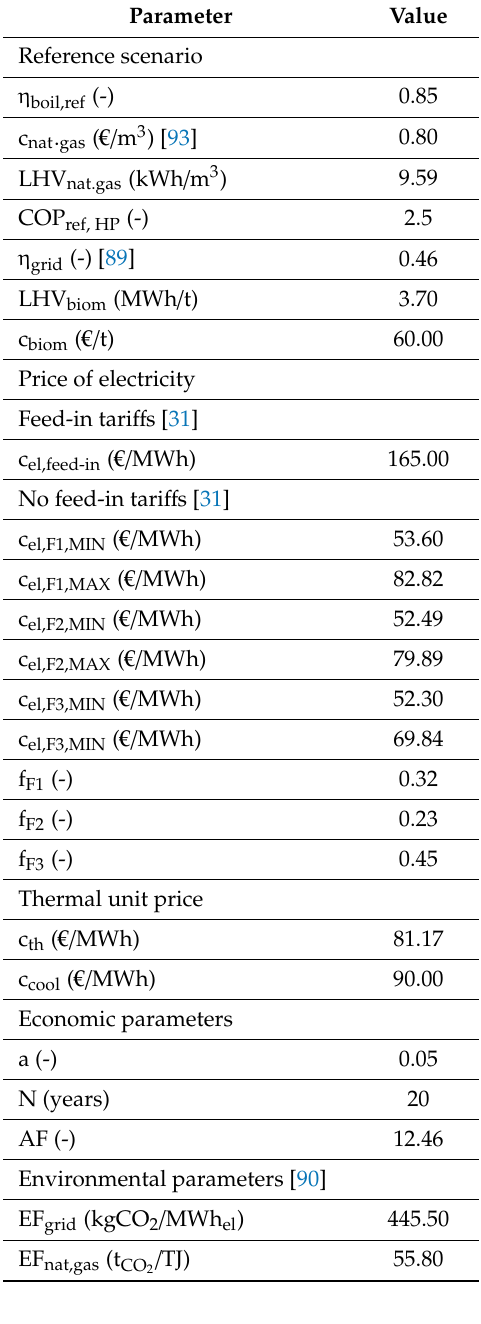
Table 4. Main input parameters for the economic and environmental